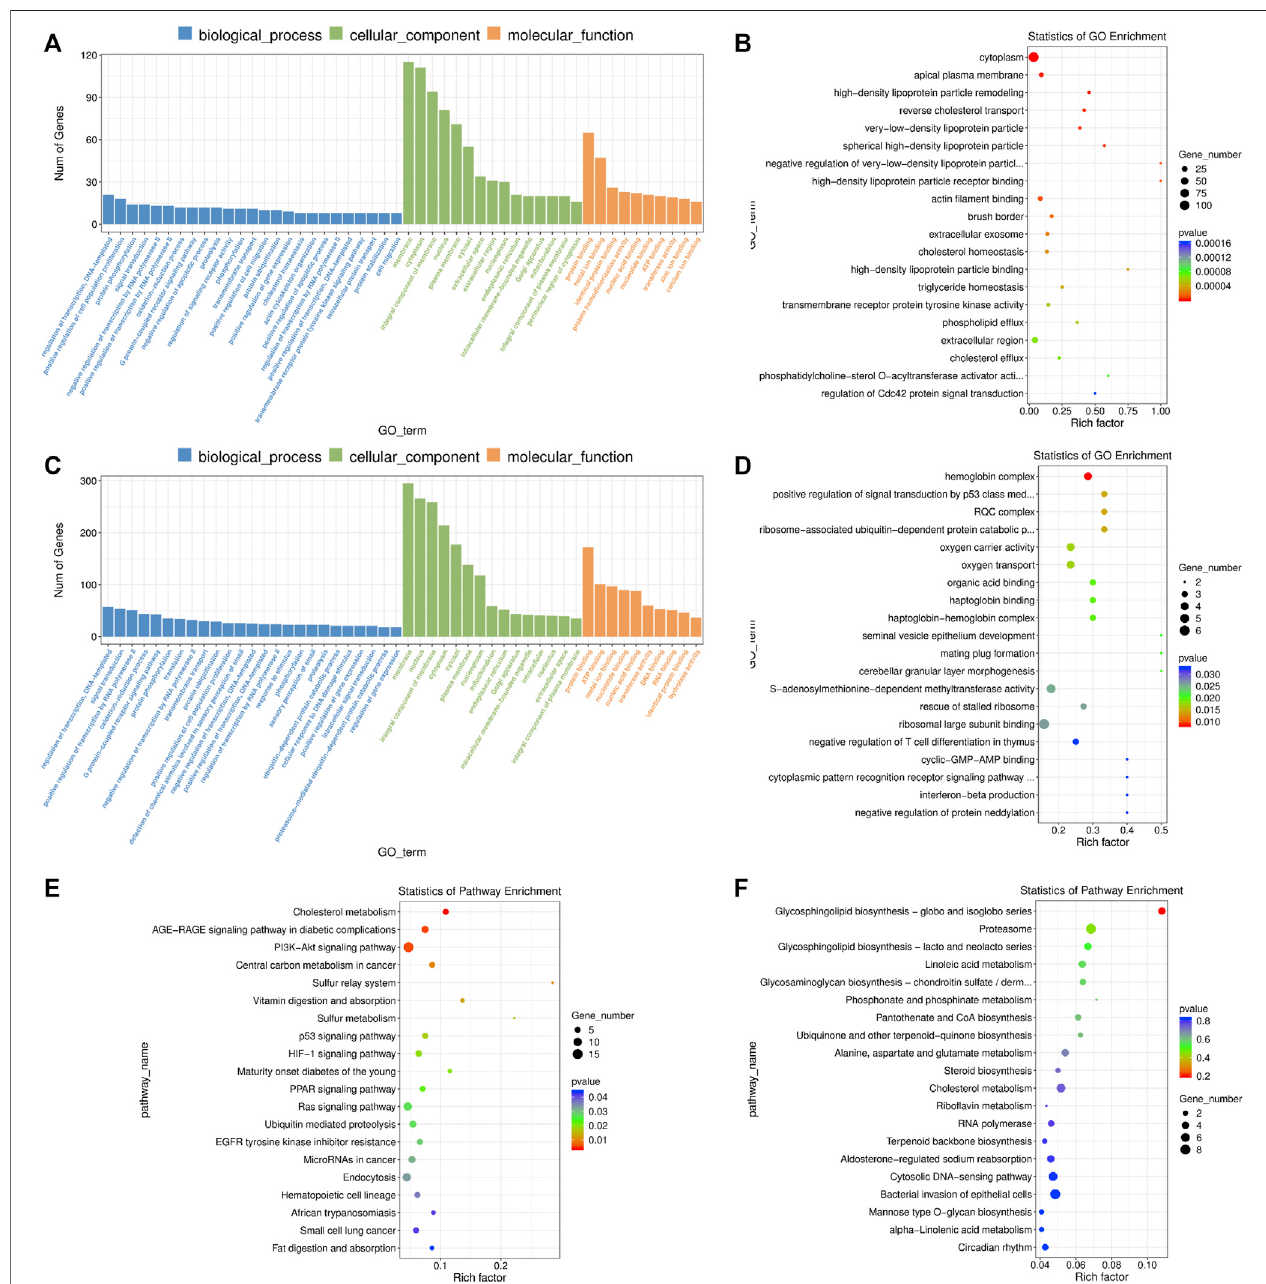
FIGURE 7 | GO and KEGG enrichment analysis of differentially expressed (DE) mRNAs and lncRNA targets in blastocysts developed from vitri fi ed porcine cloned zygotes. (A) Histogram and (B) scatter plot of GO enrichment for DE mRNAs; (C) histogram and (D) scatter plot of GO enrichment for target genes of DE lncRNAs; (E) scatter plot of KEGG enrichment for DE mRNAs; (F) scatter plot of KEGG enrichment for target genes of DE lncRNAs.